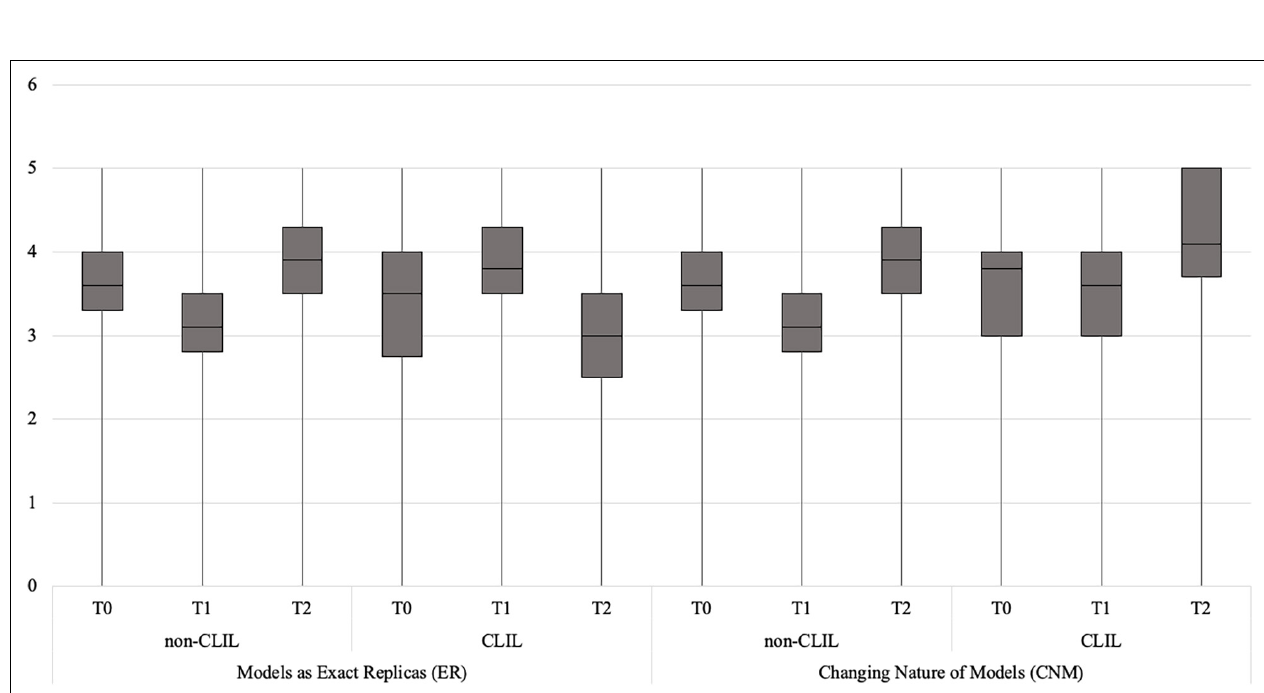
FIGURE 3 | Differences between non-CLIL and CLIL learners in “ models as exact replicas ” and “ changing nature of models ” across testing points.